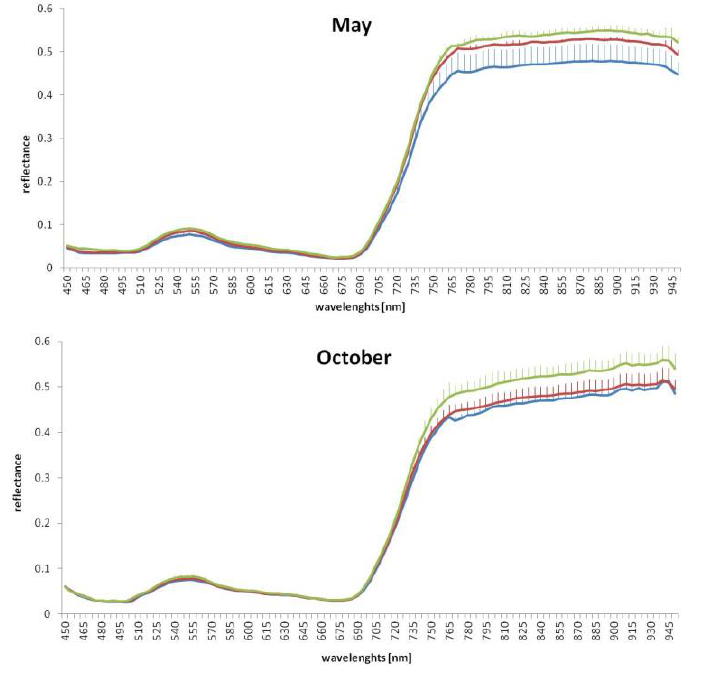
Figure 5. Average and standard deviation of the spectra for the three different levels of organic fertilization (170, 230, and 340 kgN/ha) of the May and October